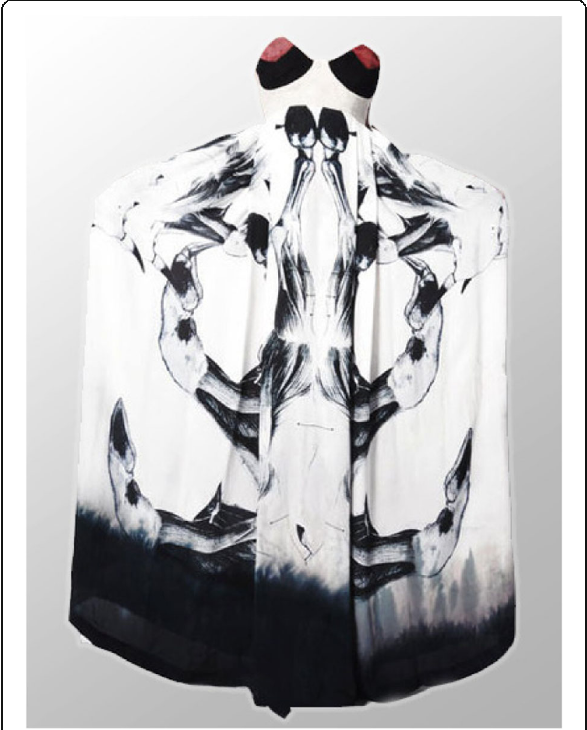
4 Results: the combination process of digital printing and traditional tie-dyeing of cashmere fabrics Digital printing of cashmere fabric with the combination of the traditional tie-dye process, this process will be digital printing with traditional tie-dye together